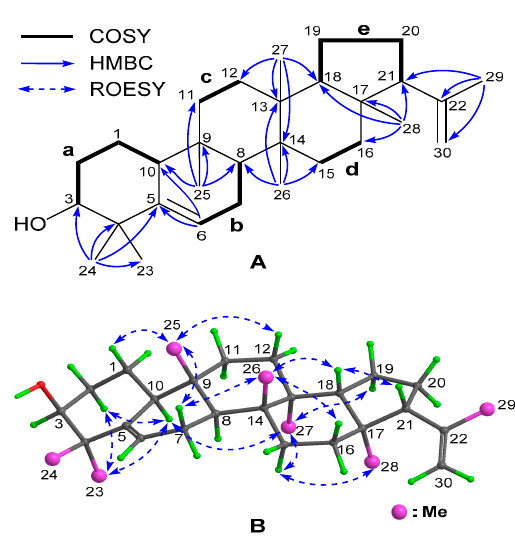
Figure 2. 1 H − 1 H COSY and Key HMBC Correlations for Compound 1 ( A ); Key ROESY Correlations for Compound 1 ( B ).